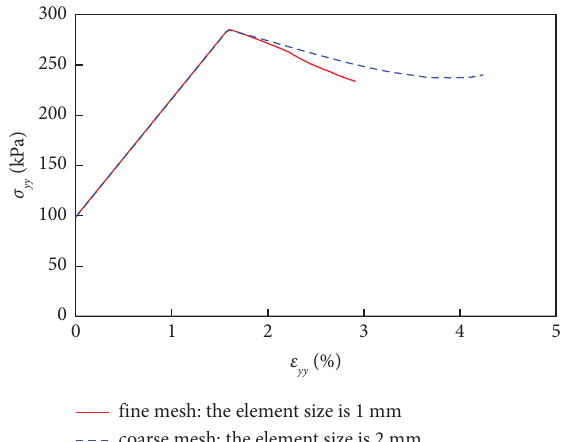
Figure 6: Stress-strain curves ( σ yy – ε yy ) of the point located in the shear band under diferent mesh densities using